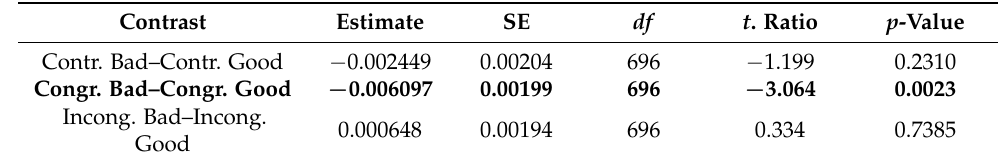
Table 6. Results of paired-contrast analysis for each Deck × Condition combination. Approximated p -values have been computed with Tukey’s correction